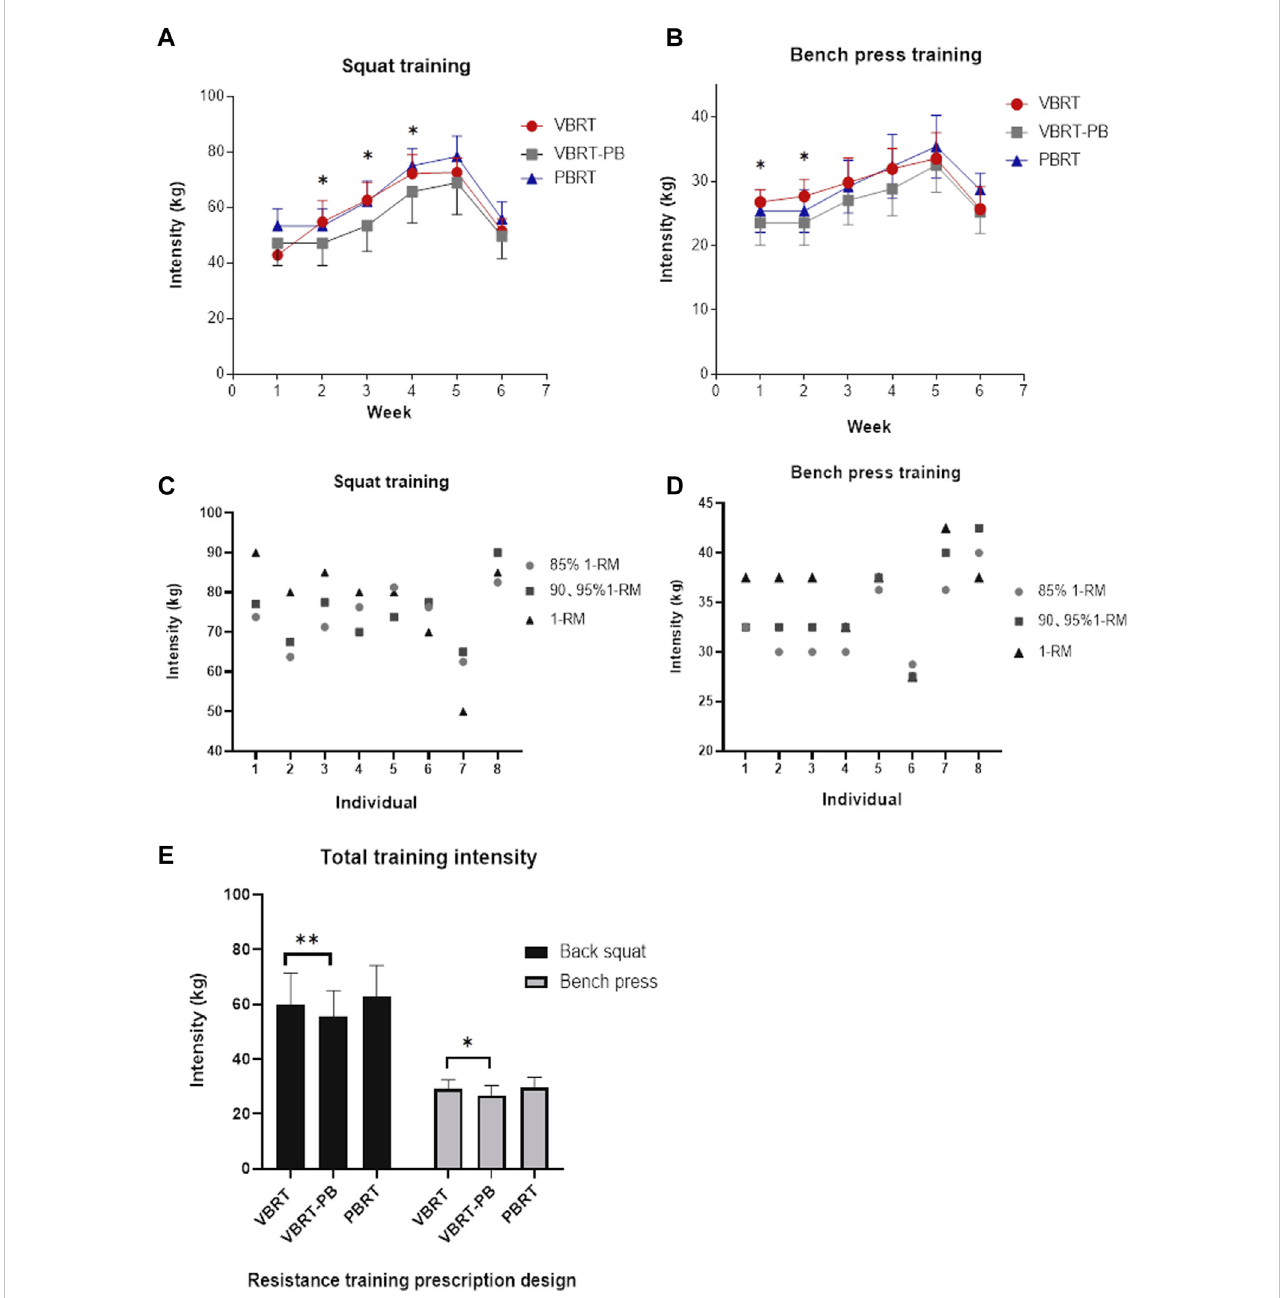
FIGURE 5 Weekly training load and average weight lifted by VBRT group and PBRT group in back squat (A) , or bench press (B) , during the heavy load (85~95%1RM) training sessions, actual weight lifted compared baseline 1RM for different participants in VBRT group in back squat (C) , and bench press (D) , during linear periodization, average weight lifted from different resistance training prescriptions in back squat or bench press (E) . VBRT: velocity-based resistance training; PBRT: baseline %1RM percentage-based resistance training. VBRT-PB: participants in the VBRT group were prescribed load with the %1RM method. *Signi fi cant difference VBRT vs. VBRT-PB; #Signi fi cant difference VBRT vs.